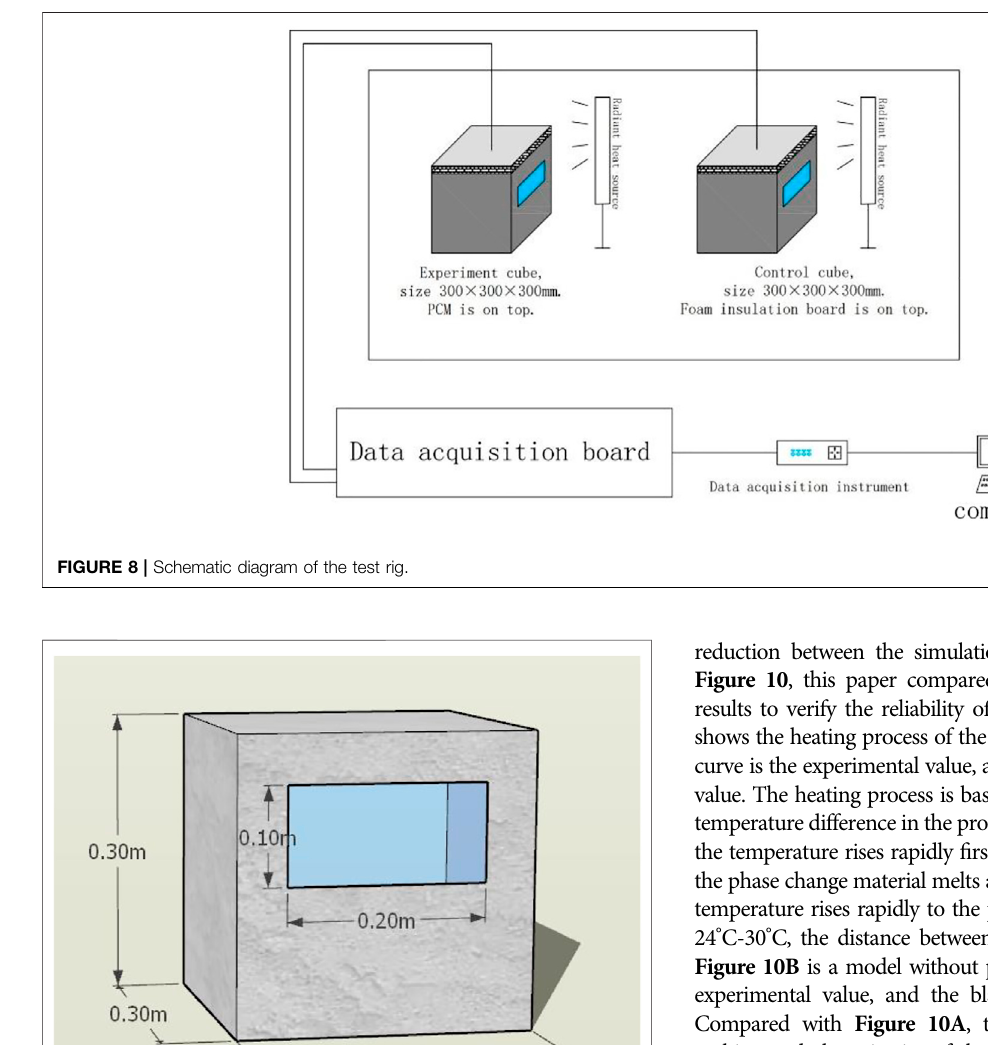
change layer is 0.9 ° C, and the maximum temperature error is 3.2 %.